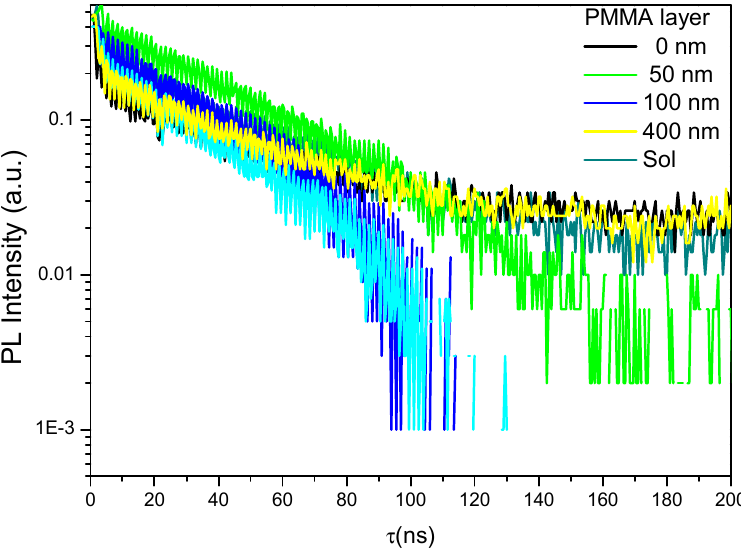
Figure 7. Time-resolved photoluminescence (PL) of CsPb(Br 0.5 Cl 0.5 ) 3 thin films, bare and with various thicknesses of polymethyl methacrylate (PMMA) as a passivation layer.